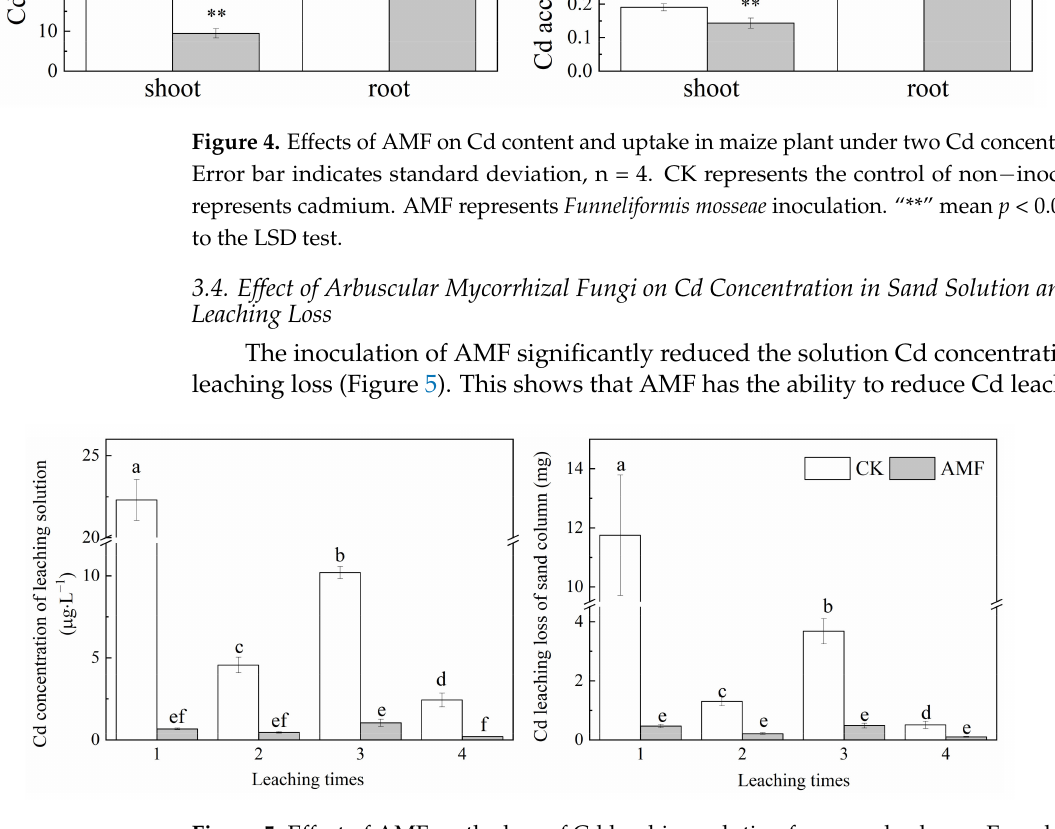
Figure 5. Effect of AMF on the loss of Cd leaching solution from sand column. Error bar indicates standard deviation, n = 4. CK represents the control of non-inoculation, Cd represents cadmium. AMF represents Funneliformis mosseae inoculation. Different little letters refer to p < 0.05 according to the LSD